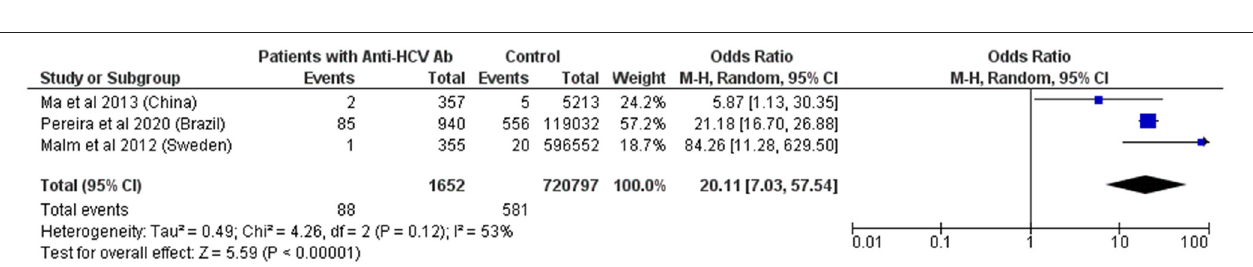
FIGURE 6 | Forest Plot and meta-analysis showing the Odds Ratio HTLV-1 infection in individuals with anti-HCV antibodies. The boxes and lines indicate the odds ratios (ORs) and their confidence intervals (CIs) for each study. The pooled odds ratio is represented by a black diamond. The size of the blue squares indicates the relative weight of each estimate. Statistical analysis and graph were performed using RevMan 5 Software. Odds Ratio was calculated using Random effects model and Mantel-Haenszel statistical method. Measures of heterogeneity between studies is shown.